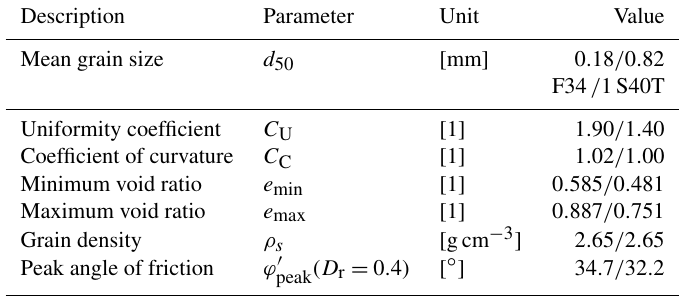
Table 4. Properties of F34 and S40T silica sands.